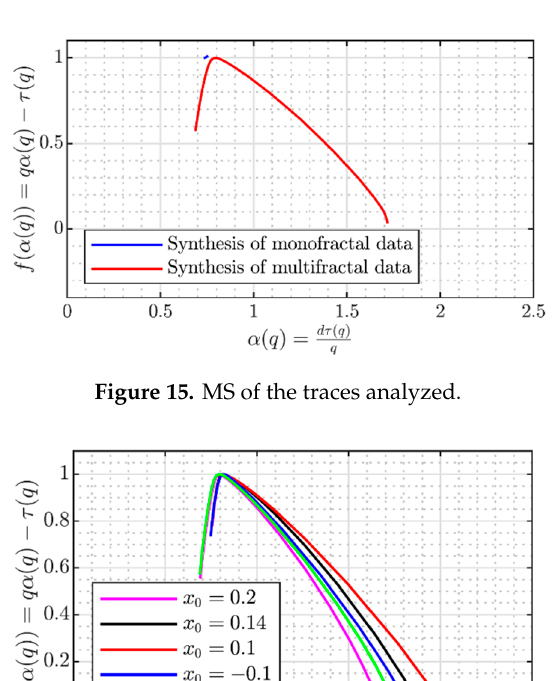
Table 4. Results of multifractal analysis of system 1.